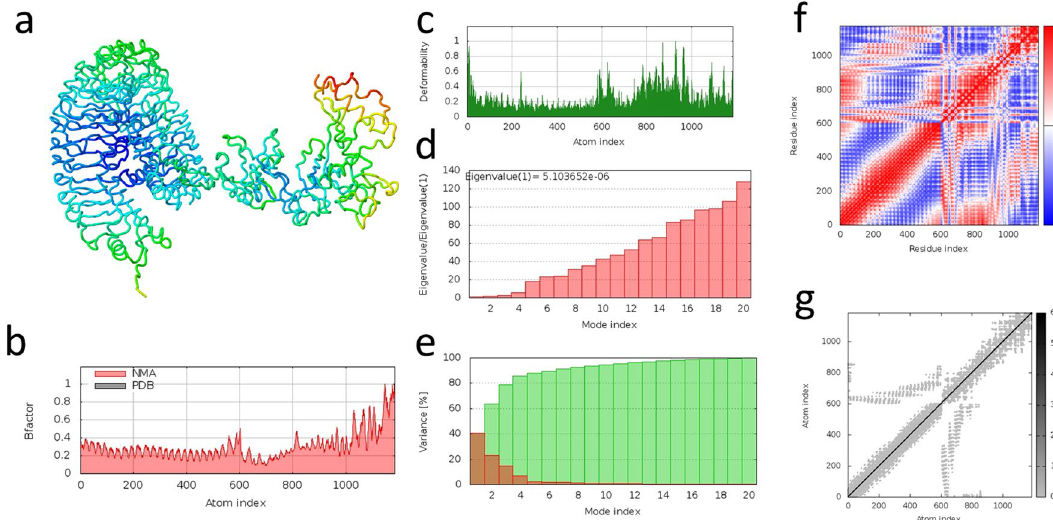
Figure 8. Molecular dynamics analysis of the TLR4 and vaccine complex by the iMODS server (https:// imods. iqfr. csic. es/). ( a ) TLR4 and vaccine docking complex Normal Mode Analysis (NMA) highlighting areas of low mobility (blue) to high mobility (red). ( b ) B-factor values with regional mobility scores from 0 (lowest) to 1 (highest). These values are experimentally similar to NMA mobility analysis in a. ( c ) Deformability index of each residue in the complex with higher values reflecting a higher capacity to deform. ( d ) Eigenvalue where the lower it is, the easier it is to deform the complex. ( e ) Variance is inversely related to the eigenvalue. Green indicates cumulative variances while red indicates individual variances. ( f ) Covariance map with correlated (red), uncorrelated (white) or anti-correlated (blue) motions. ( g ) Elastic network where darker grey areas indicate higher stiffness.